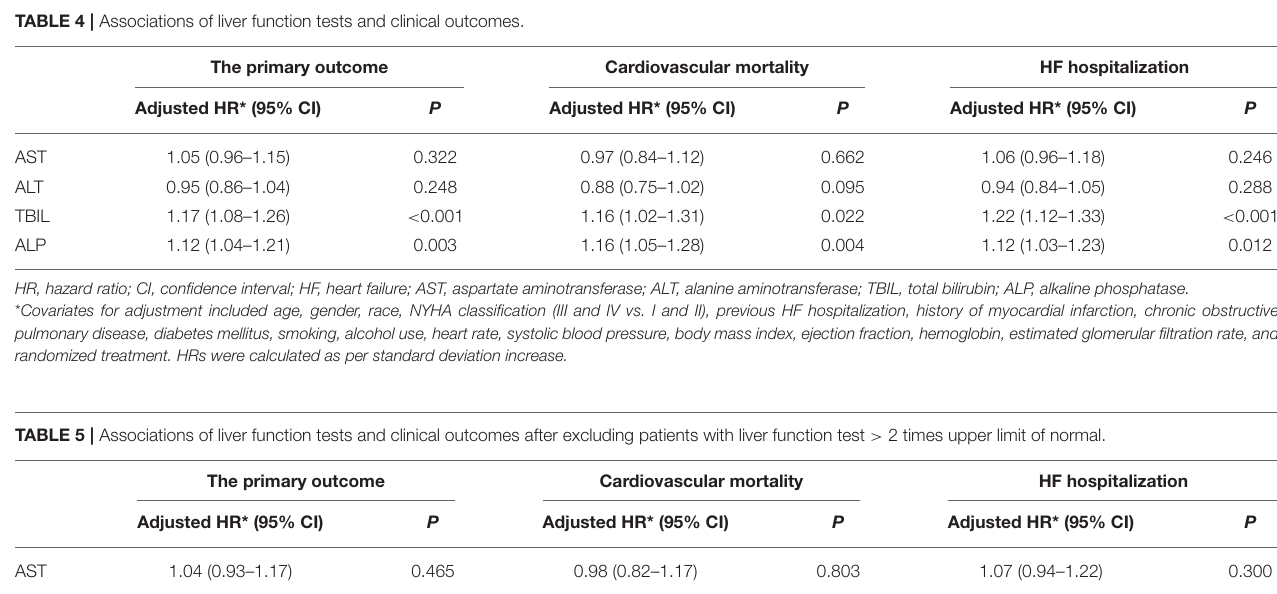
* Covariates for adjustment included age, gender, race, NYHA classification (III and IV vs. I and II), previous HF hospitalization, history of myocardial infarction, chronic obstructive pulmonary disease, diabetes mellitus, smoking, alcohol use, heart rate, systolic blood pressure, body mass index, ejection fraction, hemoglobin, estimated glomerular filtration rate, and randomized treatment.